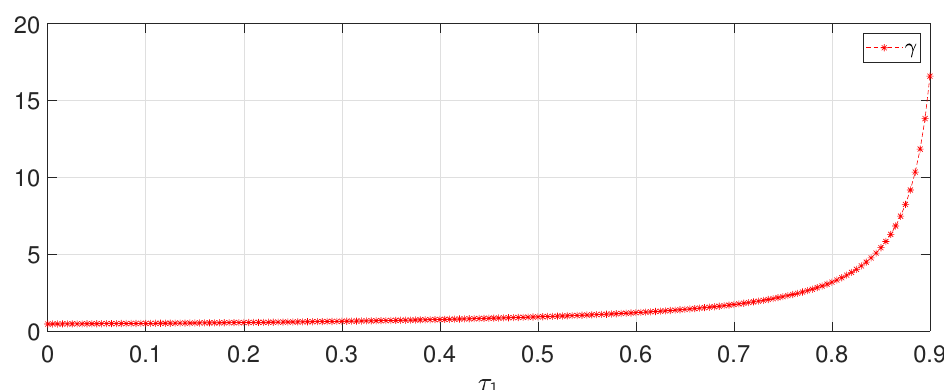
Figure 8. Minimum allowable γ for different